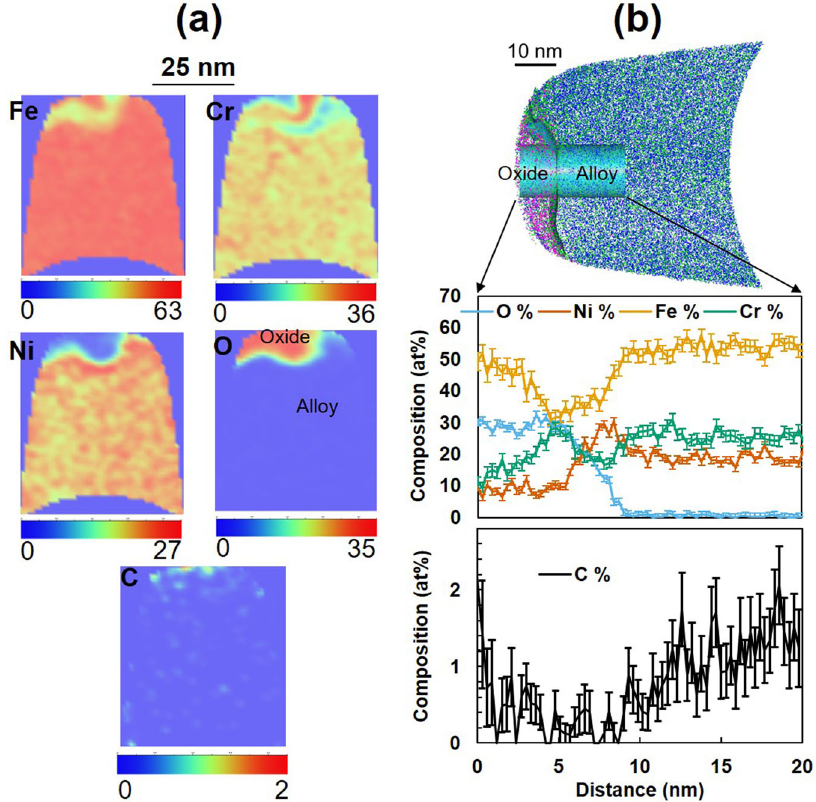
Fig. 9 APT analysis of Fe22Ni22Cr after AP-XPS in high purity CO 2 . a Two-dimensional atomic composition maps of an APT specimen that captured the oxide layer and underlying alloy. b One-dimensional compositional pro fi le corresponding to a 10 nm diameter cylindrical region of interest across the oxide/alloy interface. Error bars represent the standard counting error as described in the “ Methods ”